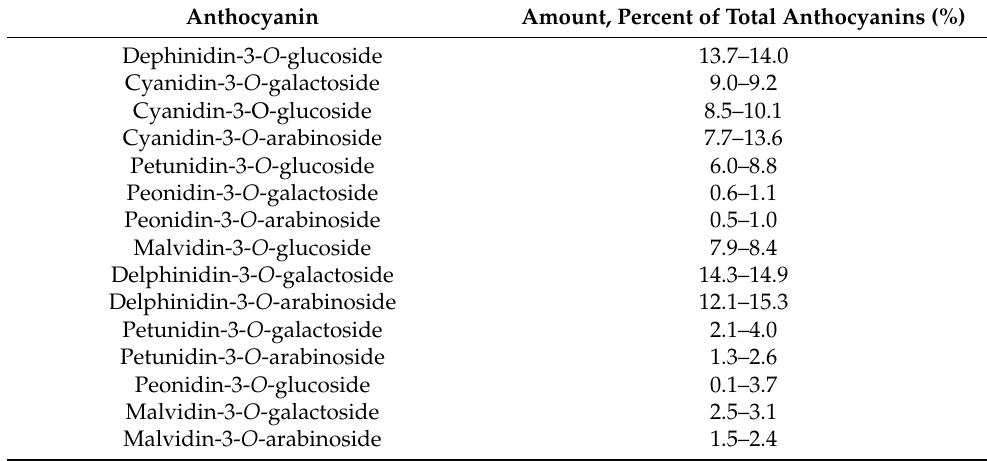
Table 3. Anthocyanin composition of bilberry ( Vaccinium myrtillus ) [64,71]. Anthocyanin Amount, Percent of Total Anthocyanins (%) Dephinidin-3- O